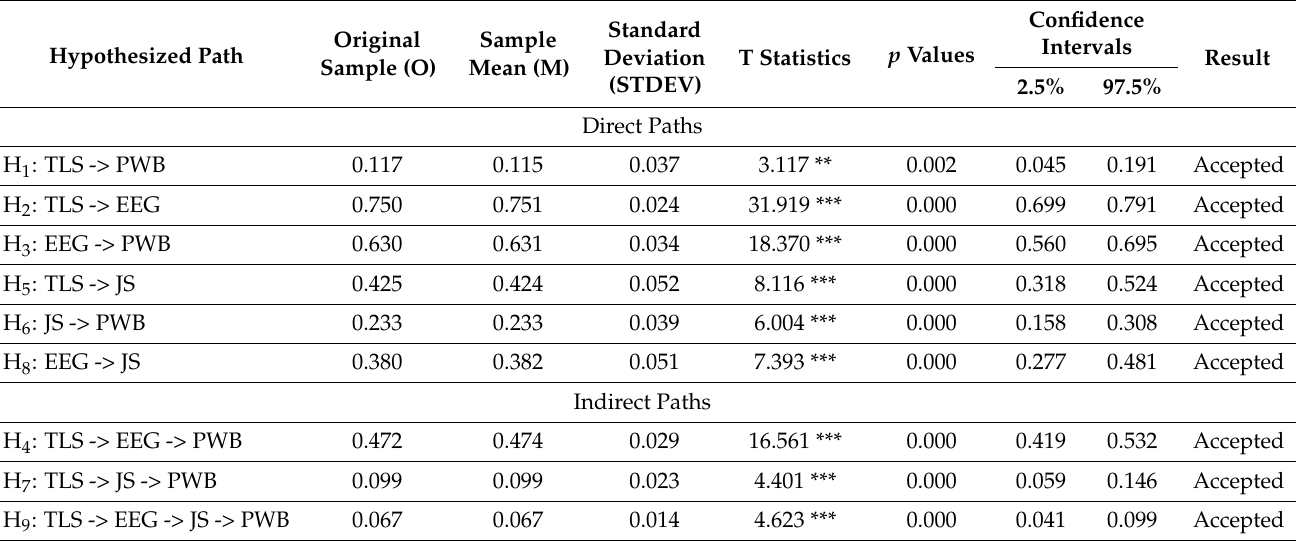
Table 6. Structural Parameter Estimates.